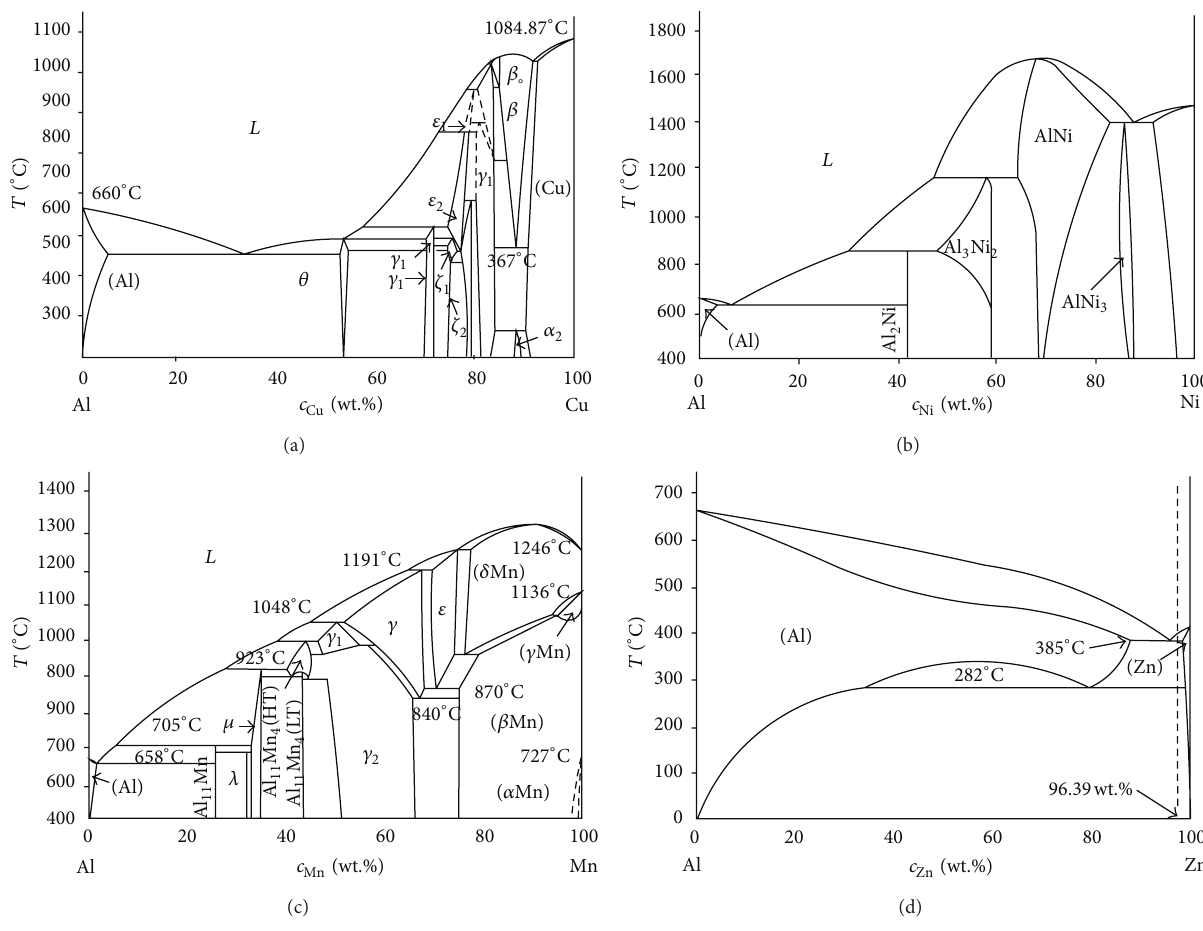
Figure 3: Binary phase diagrams of major aluminum alloying elements